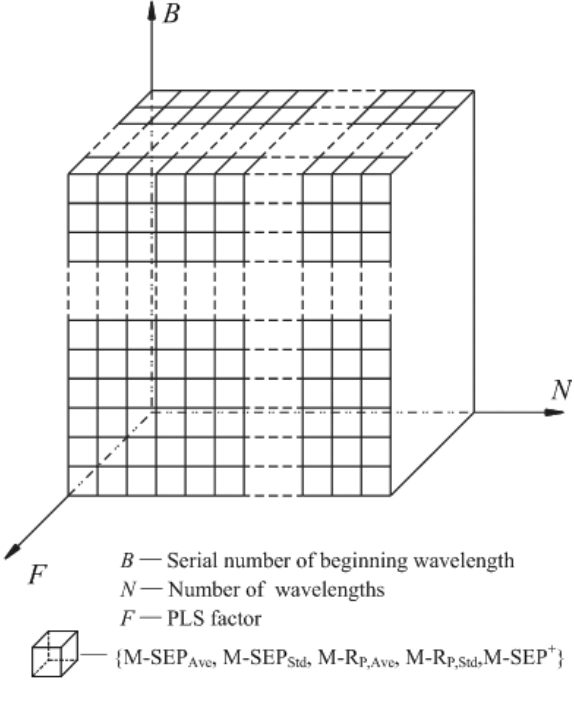
Fig. 1. Schematic of the parameter space B (cid:5) N (cid:5) F